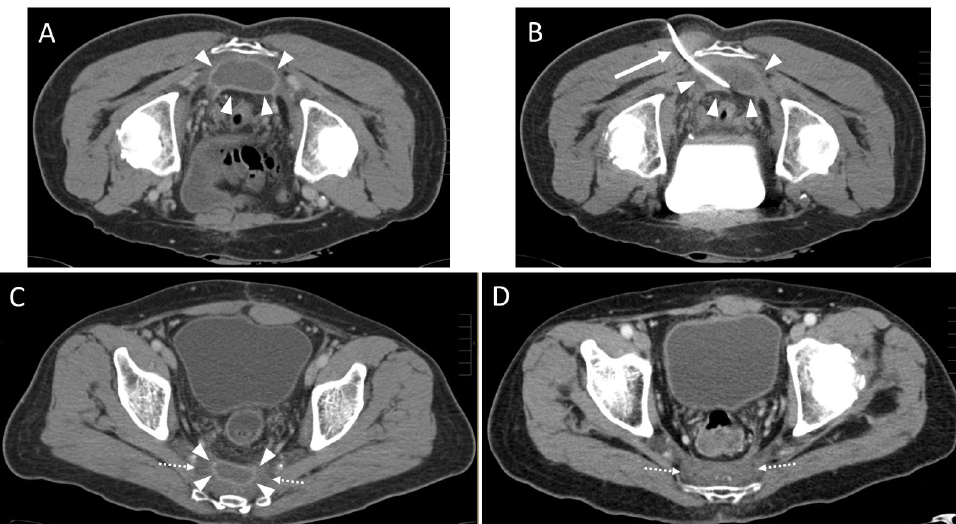
Figure 3. A 59-year-old male with history of rectal cancer (T3 tumor stage) after deep anterior rectal resection including total mesorectal excision and creation of a loop-iliostomy. A control CT scan after 9 weeks revealed a presacral contrast enhancing fluid collection. The patient had no clinical symptoms (Leukocytes: 4.1 ×10 9 /L; CRP: 0.6 mg/dL). ( A ) Preinterventional contrast enhanced CT scan in prone position showing the presacral fluid collection with rim enhancement (arrowheads). ( B ) Insertion of an 8 F drain (arrow) into the abscess formation (arrowheads). Only 20 mL of fluid could be aspirated. A microbiological analysis revealed an encapsulated hematoma infected with peptostreptococcus species. ( C ) Six weeks after the intervention, the fluid accumulation (arrowheads) showed a slight regression in size. Hypodense scar tissue (dotted arrows) had developed. ( D ) After one year the hematoma was completely resolved. Dotted arrows: scar tissue.